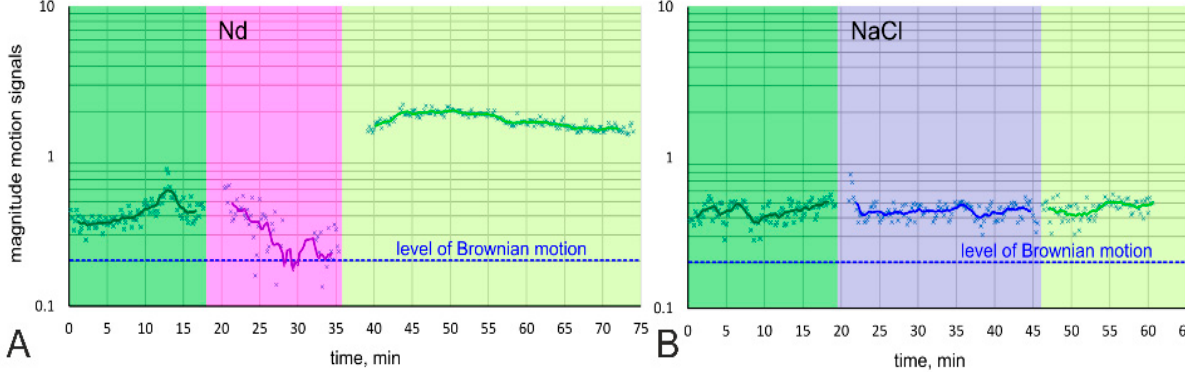
Figure 3. Diagram of changes in the magnitude of cell motility before (dark green), during (magenta), and after (light green) lanthanoid treatment ( A ) and control NaCl treatment ( B ).